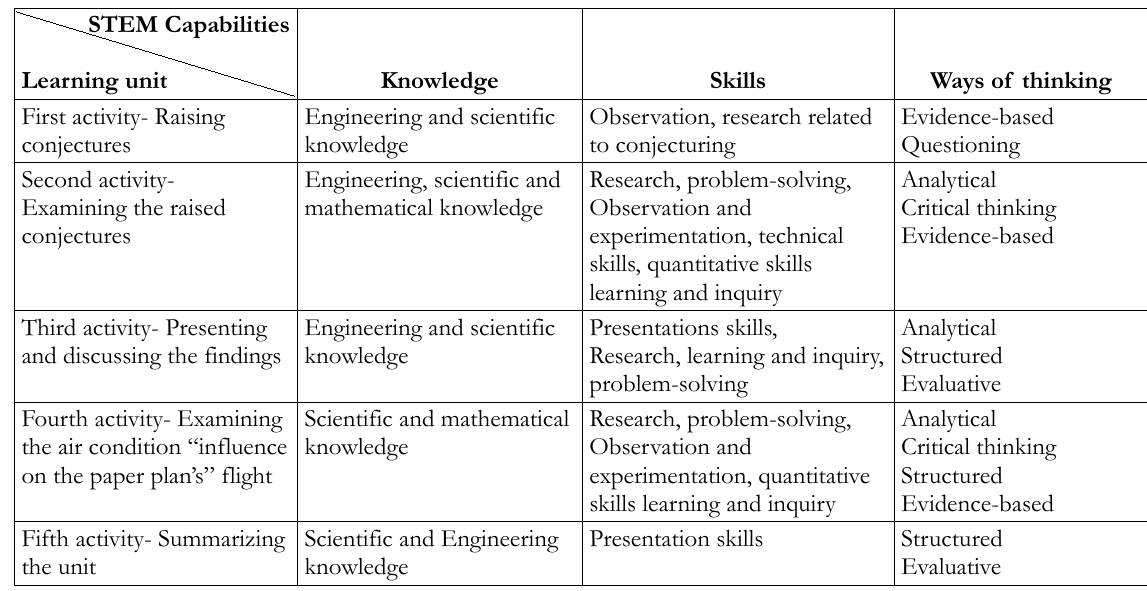
Table 4. The “paper plan” activities